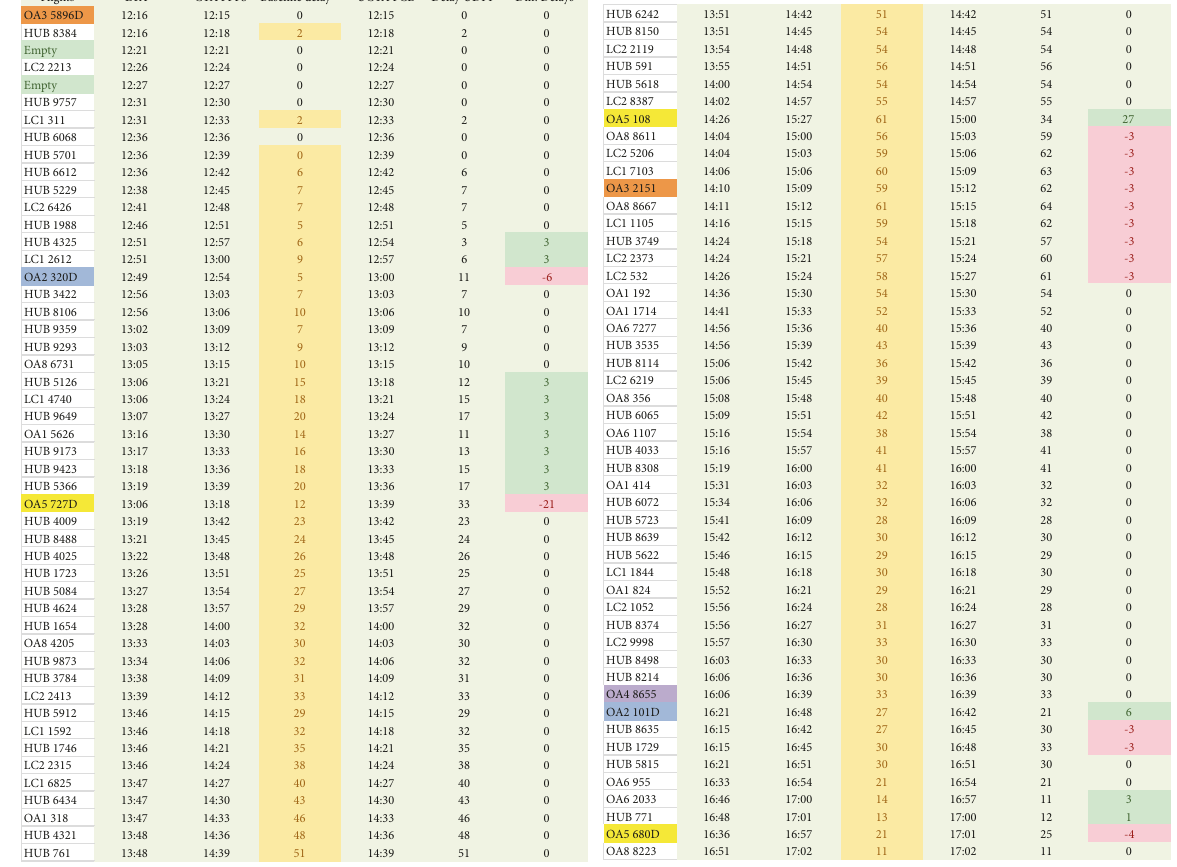
Figure 14: Impact of LVUC decision-making on the sequence and on the delay of flights (case study 2). Table 6: Effect of sequence compression on the distribution of delay (case study 2). AU name Total flights Baseline